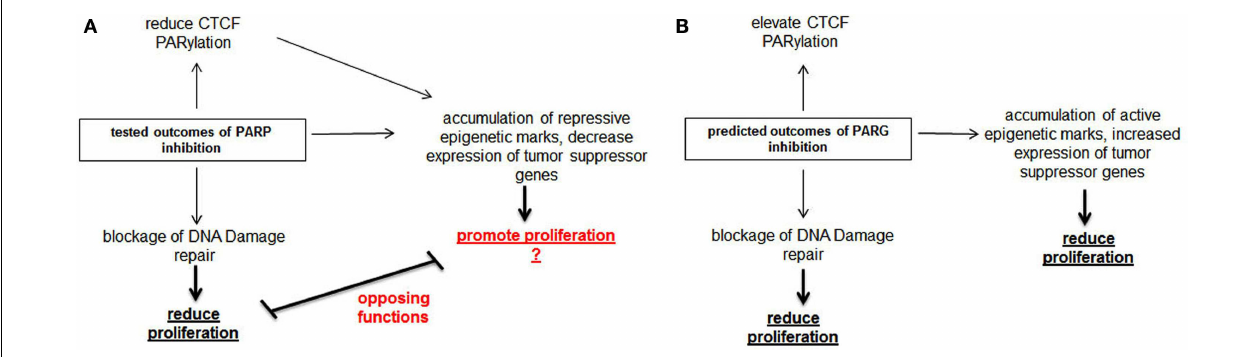
FIGURE 2 | Comparison of molecular action of Parp inhibitors with predicted action of Parg inhibitors. (A) Parp inhibitors inhibit the growth of Brca mutated tumors through blocking DNA damage repair. Parp inhibitors also dePARylate Ctcf, cause the accumulation of repressive epigenetic marks at tumor suppressor genes and diminish the expression of these genes.We